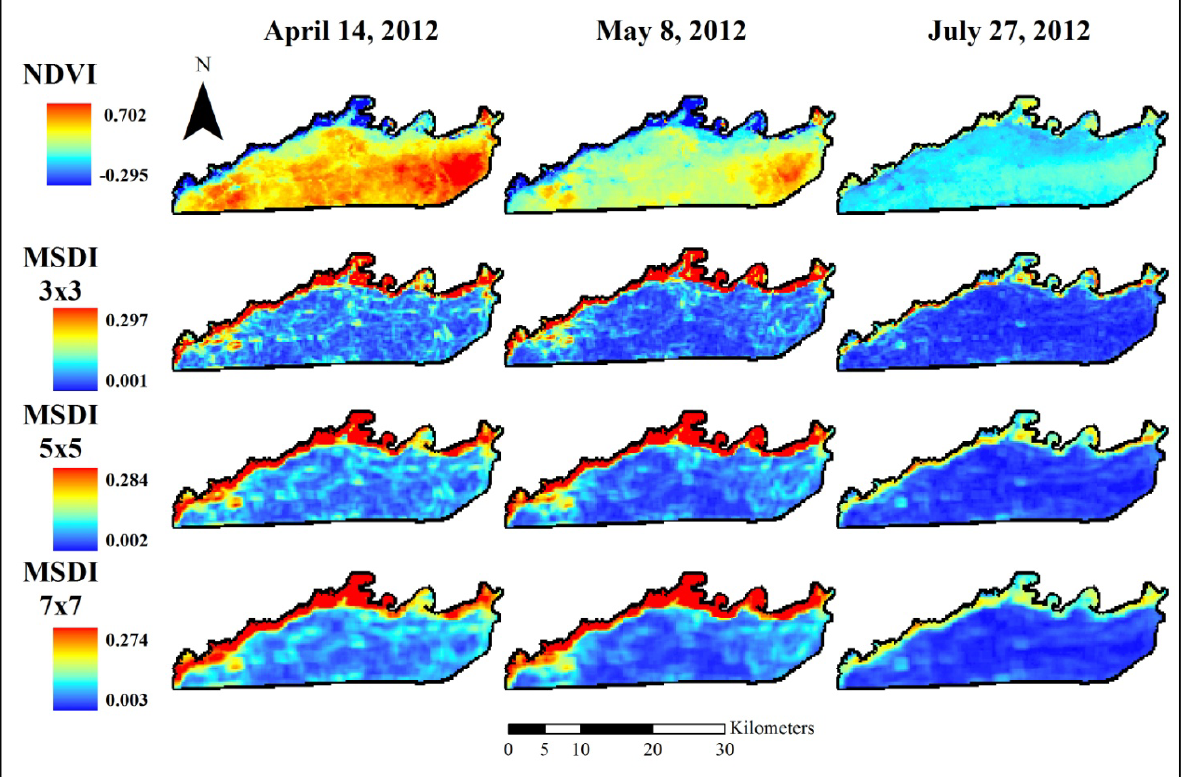
Figure 3. Normalized difference vegetation index (NDVI) data used to assess elephant utilization of vegetation along the Chobe riverfront, Chobe National Park, Botswana. The top row shows the base images for the three dates assessed in this project. Subsequent rows show the Moving Standard Deviation Index (MSDI) values calculated using 3 × 3-, 5 × 5-, and 7 × 7-pixel moving windows, respectively. These indices are unitless. NDVI ranges from − 1 to +1 while the MSDI has a minimum value of zero and a maximum determined by the